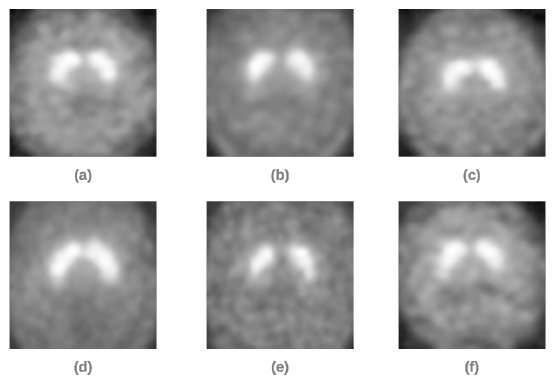
Figure 2. Sample images ( a – f ) from PPMI dataset for a person not suffering from PD.